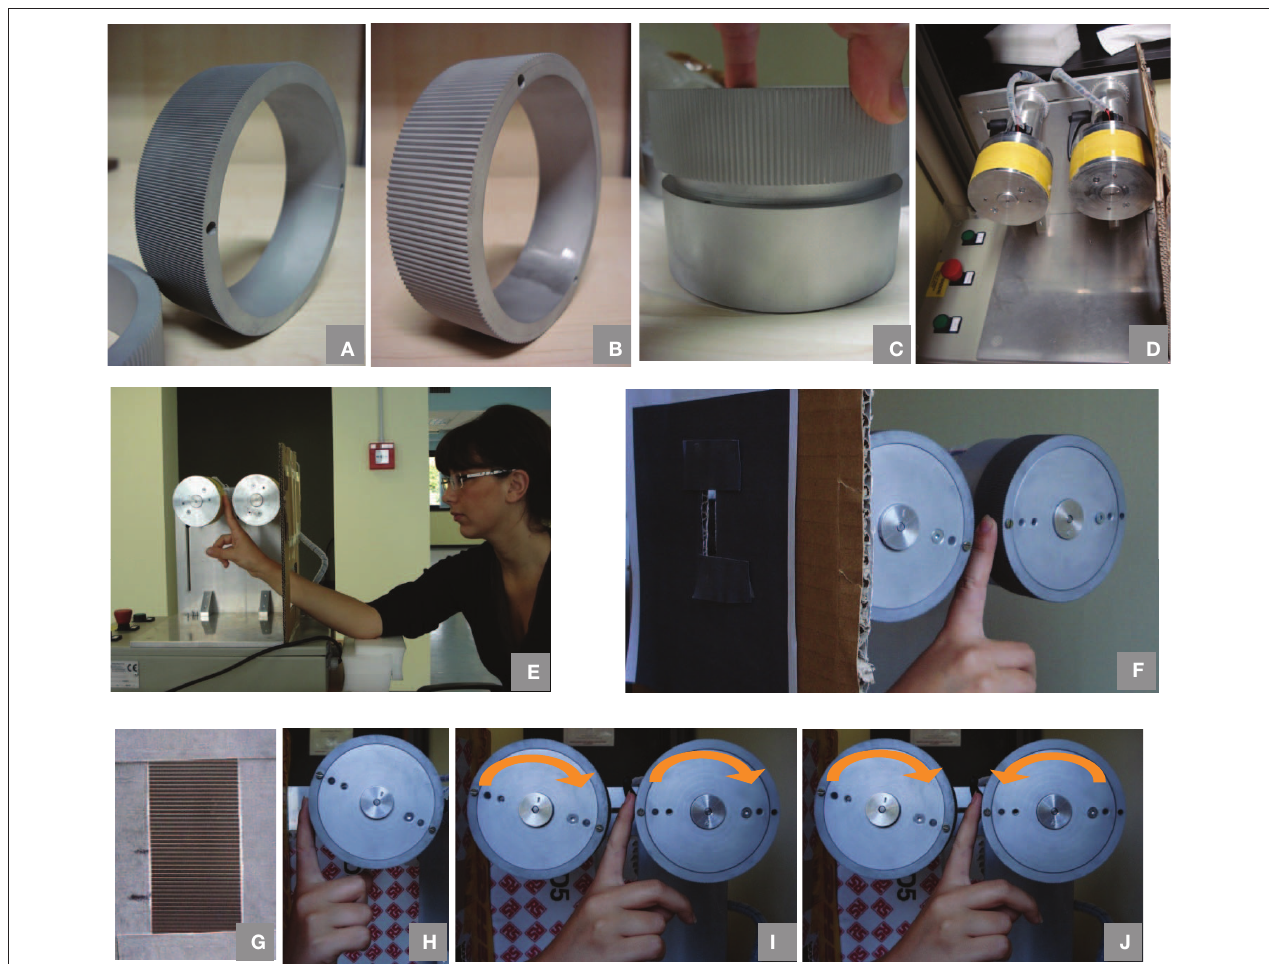
Figure 2 | Stimuli: physical wheels etched with a sinewave profile of different spatial frequencies: (A) 10 cycles/cm and a phase of 1 mm, (B) 3.3 cycles/cm, and a phase of 3 mm. (C) Support where the wheels were inserted. (D) Setup with two arms driven at variable speeds by two independent computer controlled